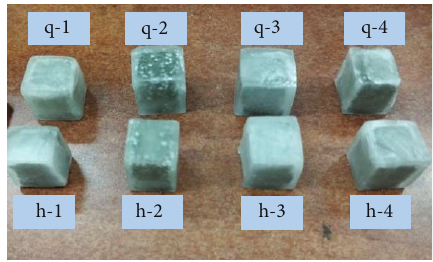
Figure 5: Wax-seal tailing sand sample.